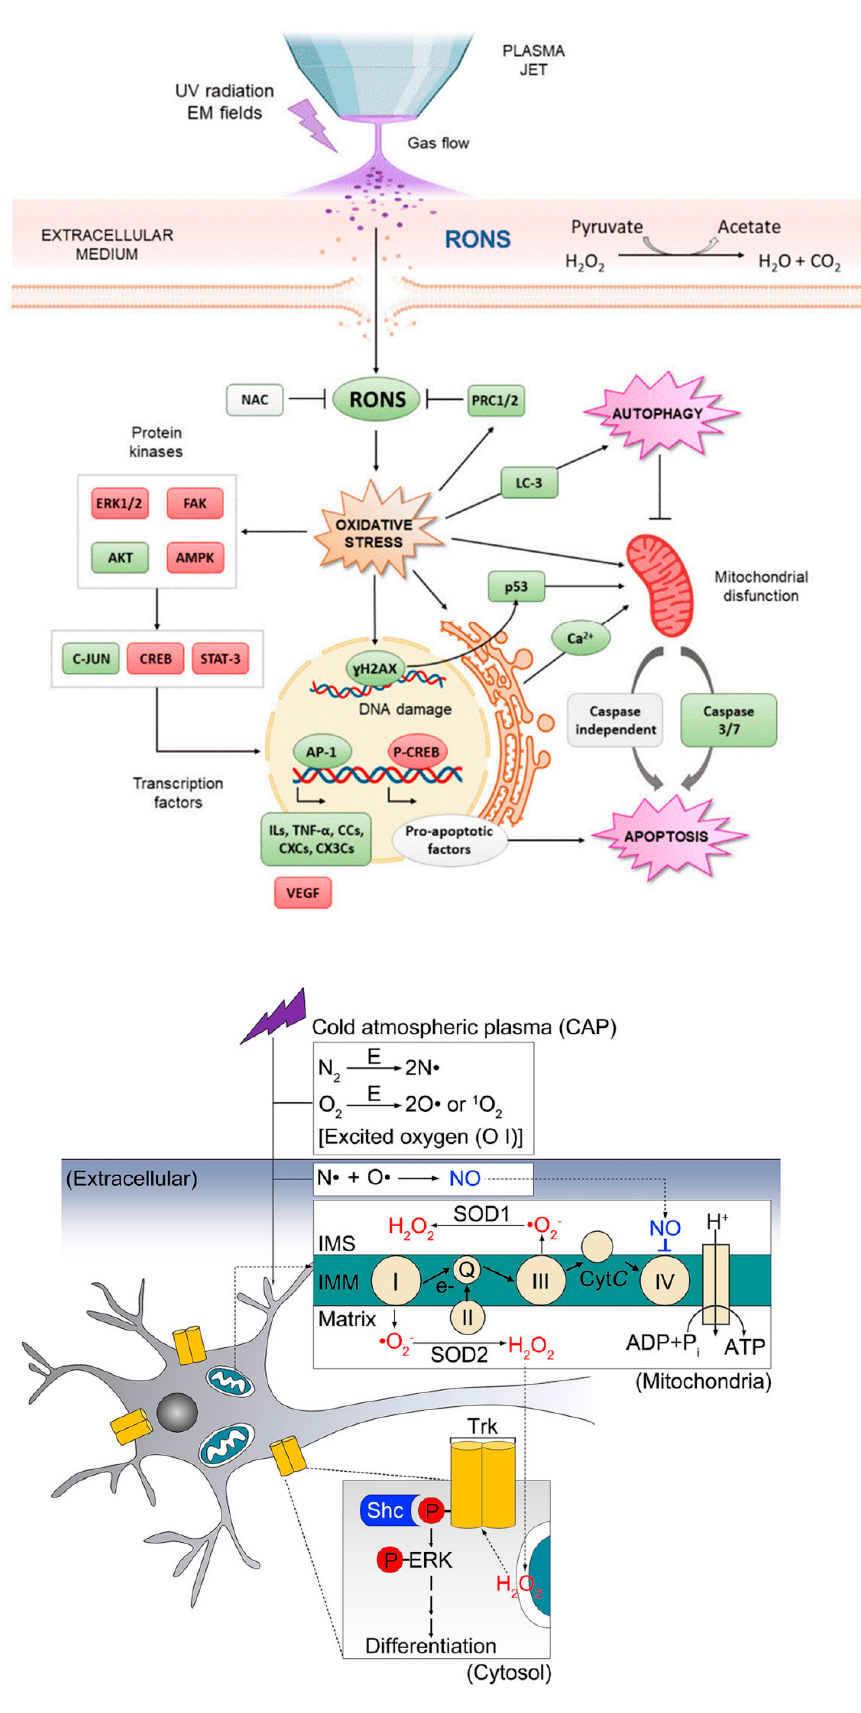
Figure 4. Plasma-induced oxidative stress-mediated signaling pathways proposed in the literature ( top ). In osteosarcoma therapy, according to Mateu-Sanz et al., pyruvate scavenges hydrogen peroxide in